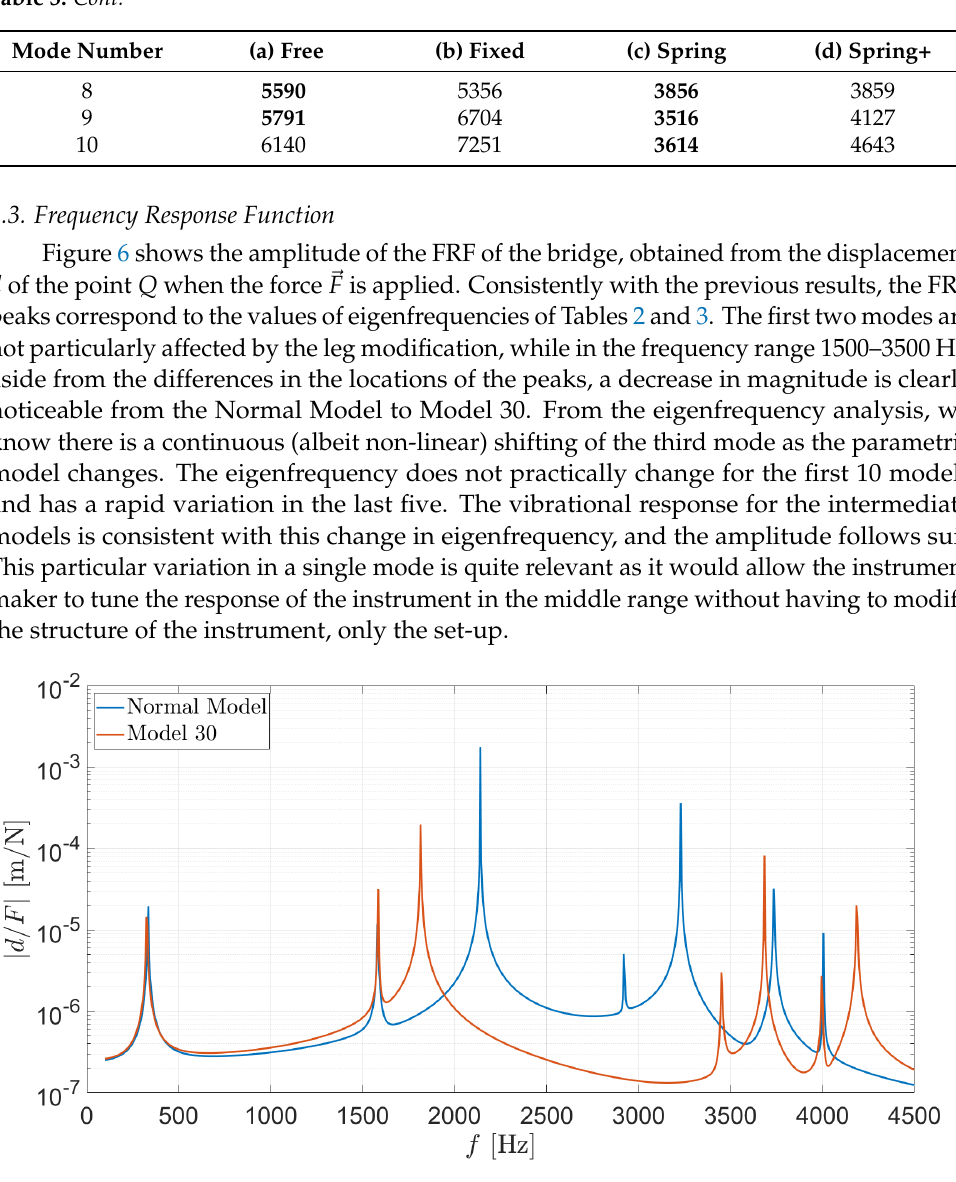
Figure 6. Frequency Response Function of the Normal Model and of Model 30. The FRF is computed between the nominal excitation force F and the displacement d of point Q, located at the hip of the bridge. The frequency resolution is 5